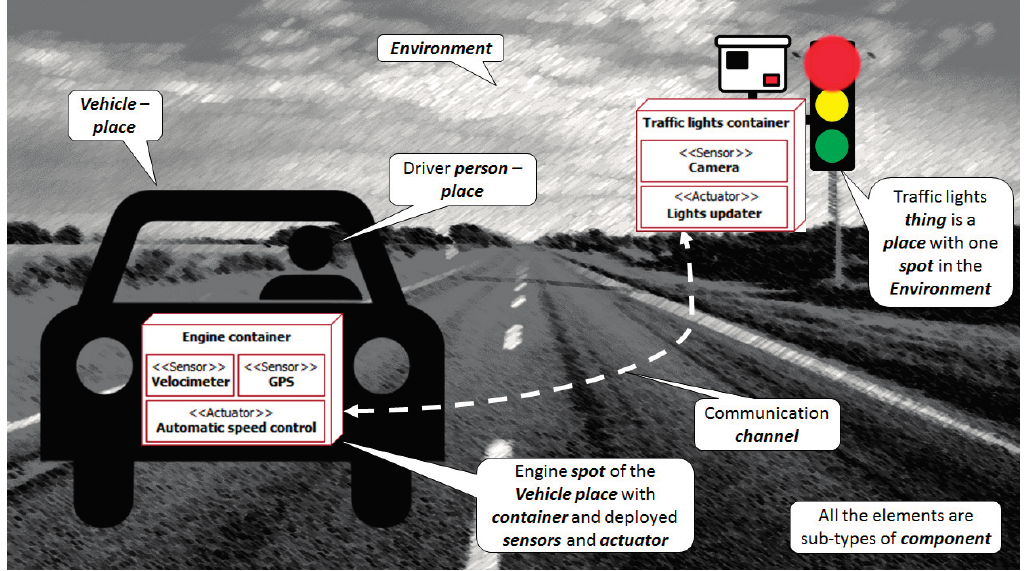
Figure 2. Main concepts (in italics ) of the ITS Modeling Language (ITSML) in